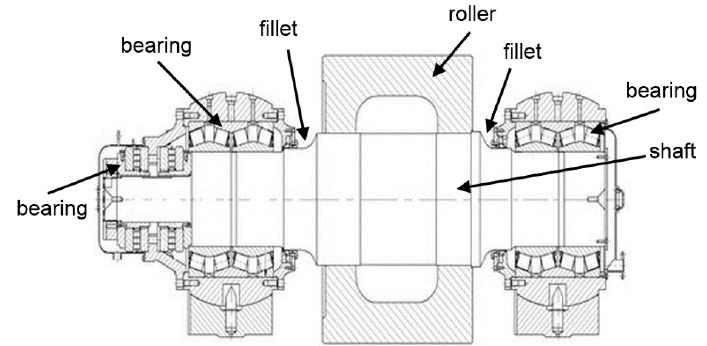
Figure 16. Roller support.